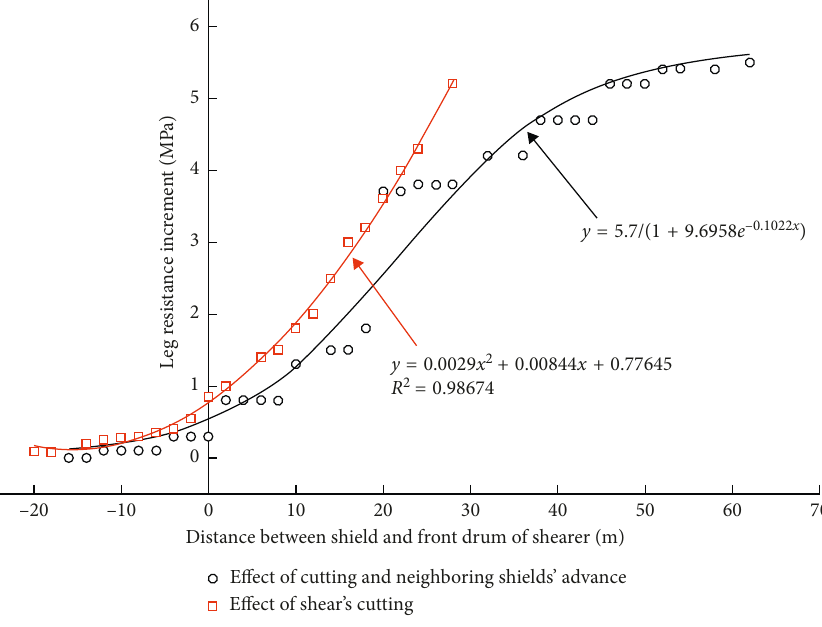
Figure 12: Relationship between leg pressure increment and the distance between shield and front drum of shearer under the independent influence of drum cutting and the combined influence of shearer’s cutting and neighboring shields’